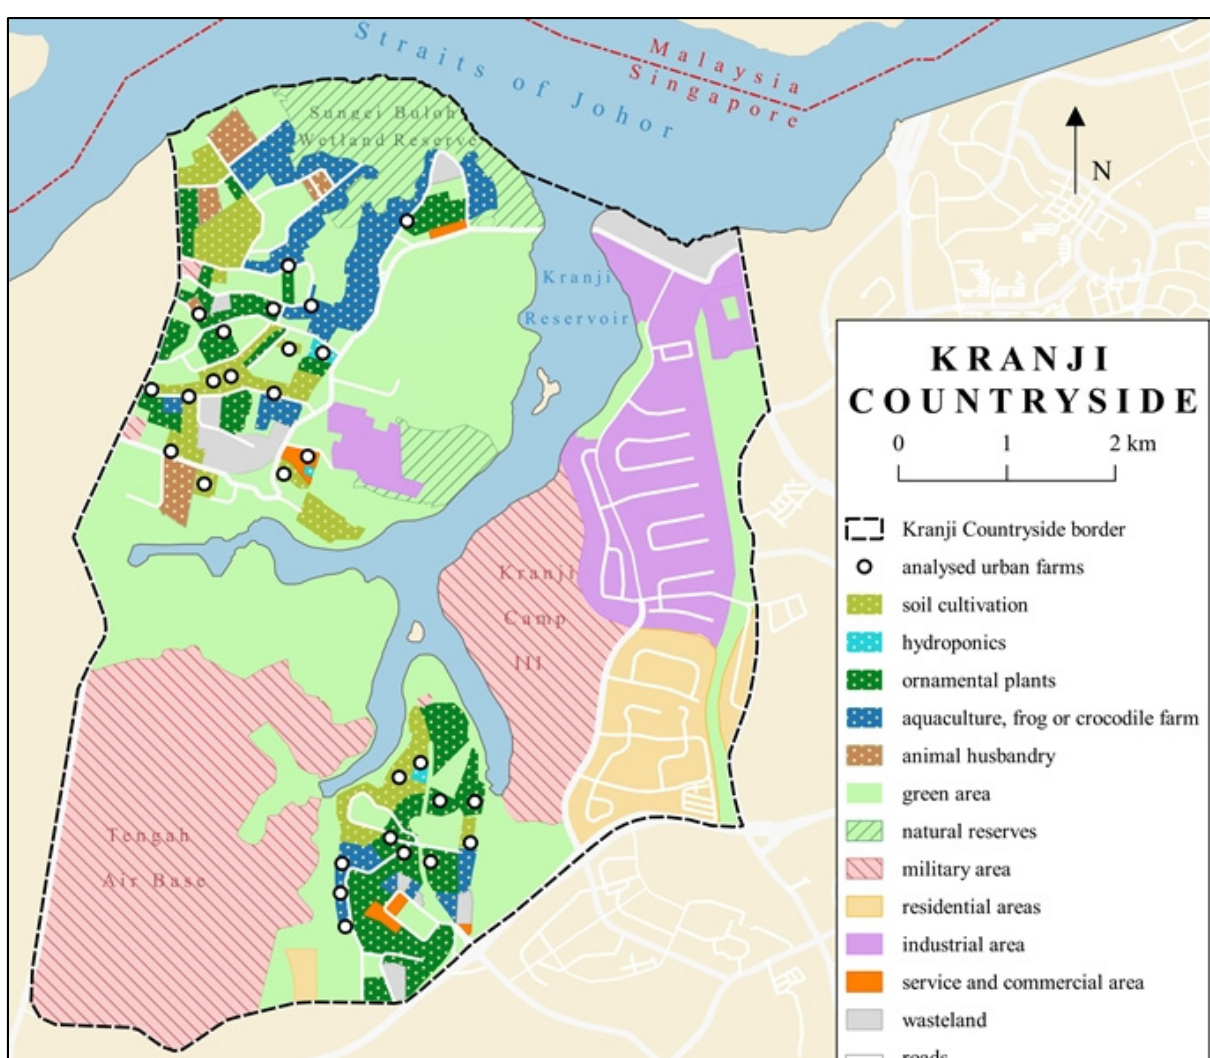
Figure 2. Land use and spatial distribution of urban farms within the Kranji Countryside. The second group of farms in Singapore coming under study comprises eight sites of a total area of 10 ha and mean area of 1.25 ha, located in the central districts where transport links are good. Three are located in the south of the island and five in the north, on either side of the Lower Seletar Reservoir. On account of the high-density built-up area, sitting urban farms in central parts of Singapore is very much hindered and requires appropriate adaptive measures. Thus, for example, one of the farms—owned by Comcrop—is on the roof of the *SCAPE Mall, less than 200 m from one of Singapore’s main transport arteries, Orchard Road (Figures 3 and 4a,b). A rooftop location denotes appropriate methods of production that revolve around soil-free hydroponics.